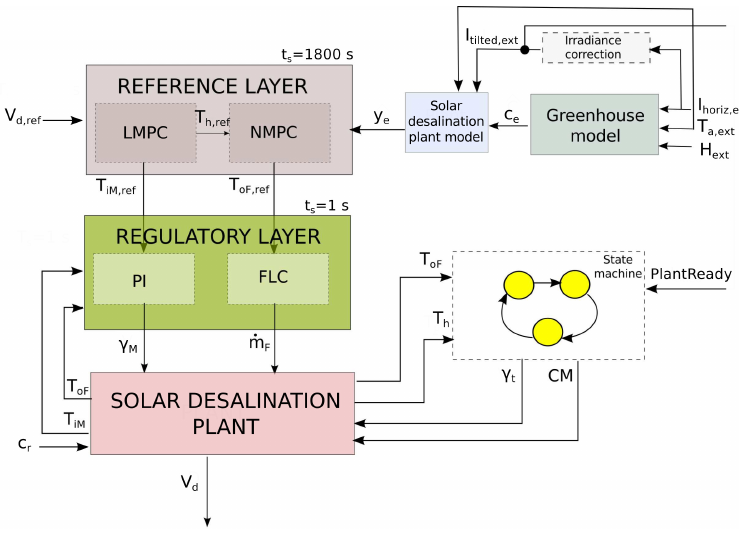
Figure 6. Proposed control scheme to obtain a desired volume of